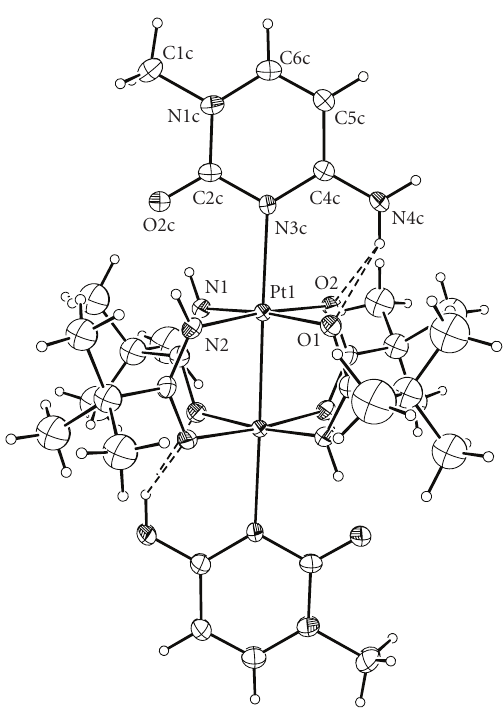
Figure 3: View of the [Pt 2 { HN = C(Bu t )O } 4 (1-MeC) 2 ] 2+ complex showing the atomic numbering scheme of most important atoms. The tert -butyl groups are disordered and can occupy two di ff erent positions; only one position is shown for clarity. Displacement ellipsoids are drawn at 20% probability